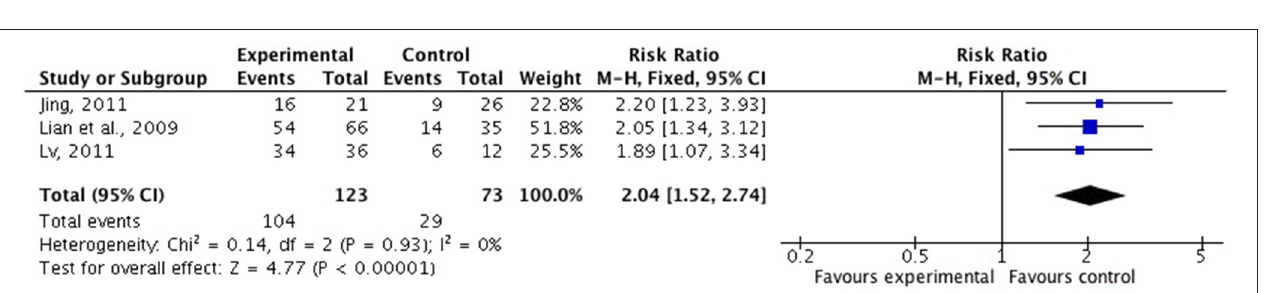
Frontiers in Pharmacology |